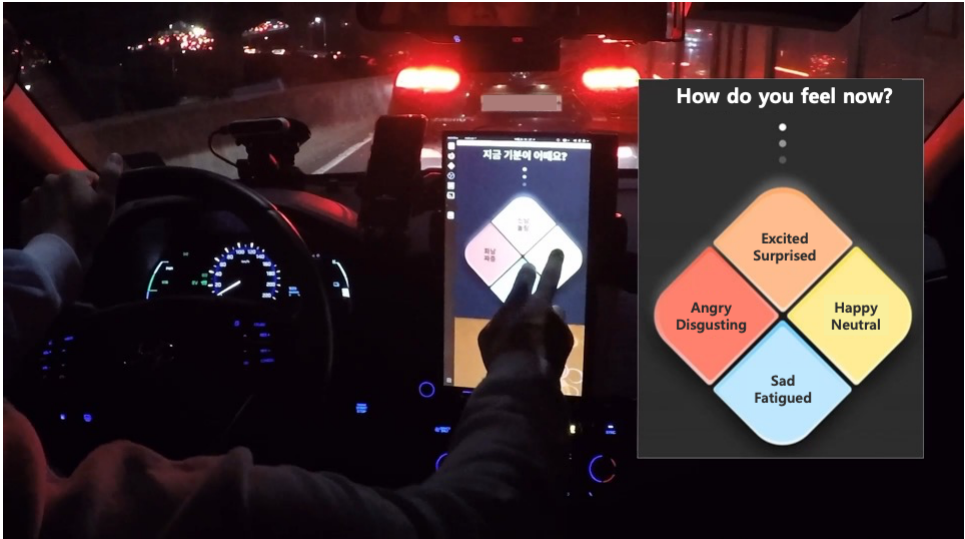
Figure 1. A scene in which a driver’s emotional state data is being collected during real-world driving using the proposed data collection system. The driver is self-reporting their emotional state by touching the HMI application mounted on the vehicle center fascia. The screenshot on the right is the English translation of the GUI of the HMI application implemented in